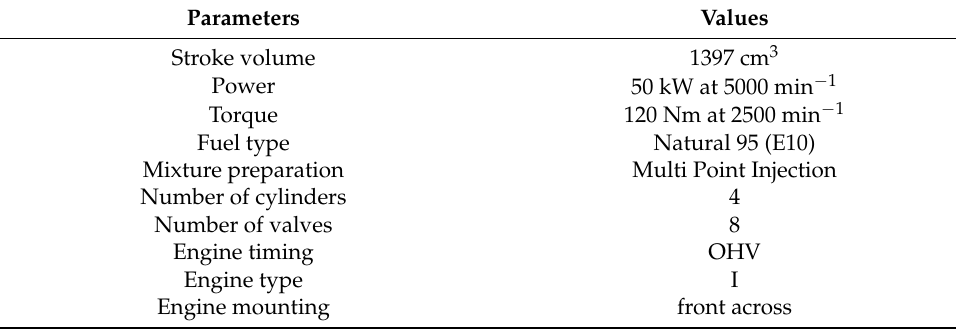
Table 1. Parameters of the engine Skoda 1.4 MPi.